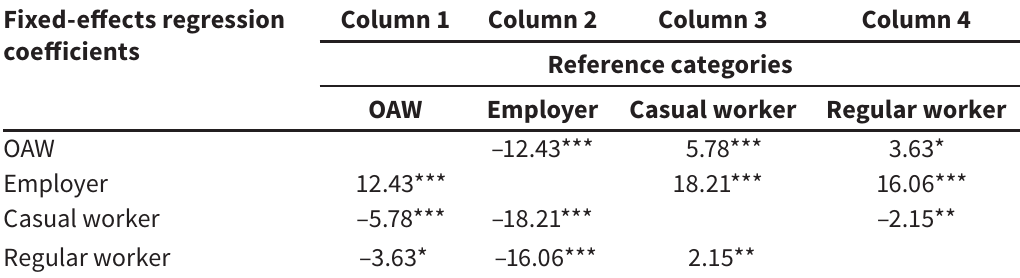
Fixed-effects regression